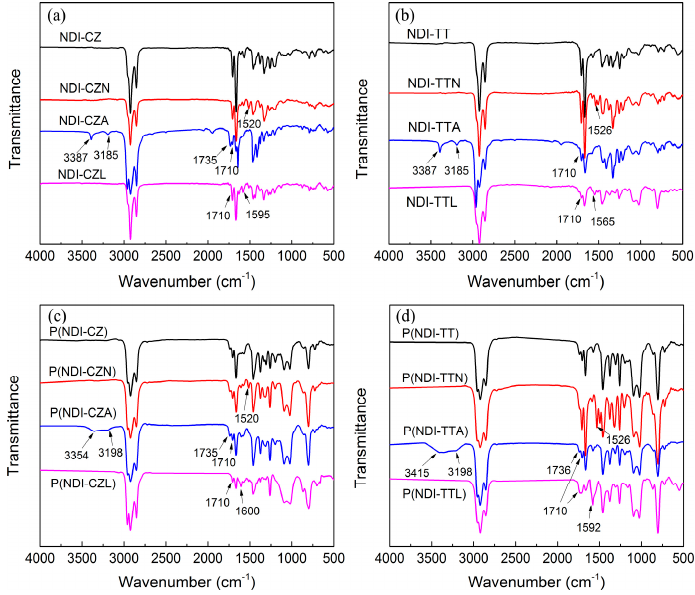
Figure 4. FTIR Spectra of compounds and copolymers before and after ladderization. ( a , b ) for compounds; ( c , d ) for copolymers.